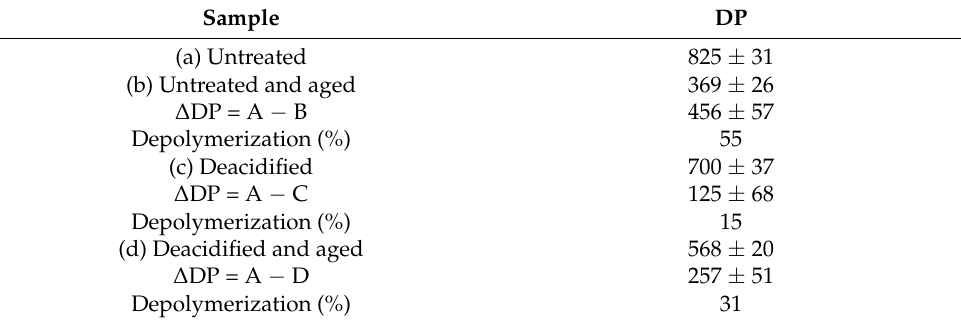
Table 4. Paper’s DP before and after deacidification treatment and aging test. The standard deviation on the DP is between 5 and